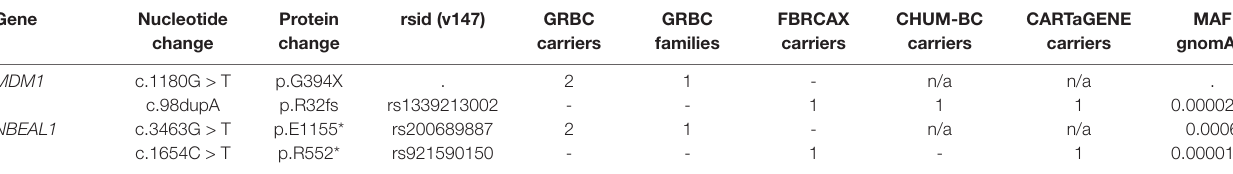
TaBlE 1 | Genes with rare LoF variants in individuals from GRBC, FBRCAX, CHUM-BC, and